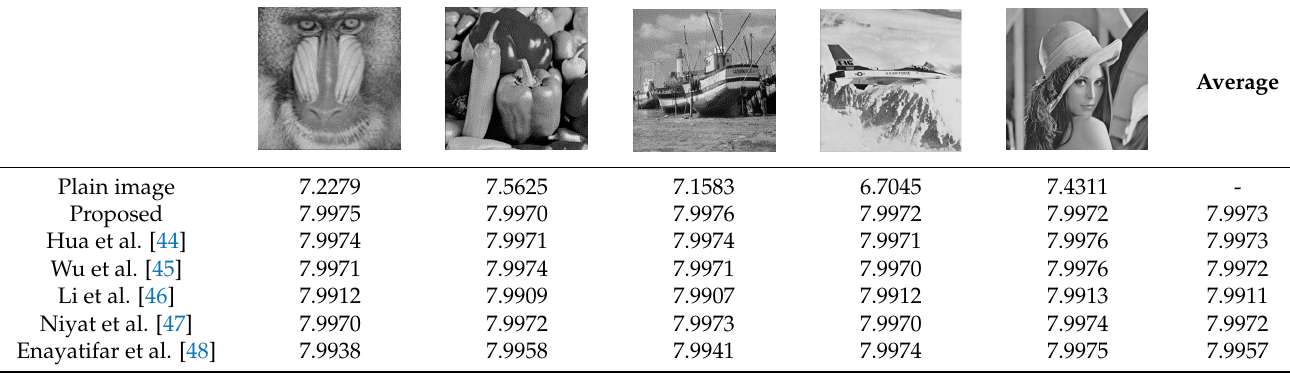
Table 2. Entropy values of images with size 256 × 256 with our algorithm and other encryption algorithms.